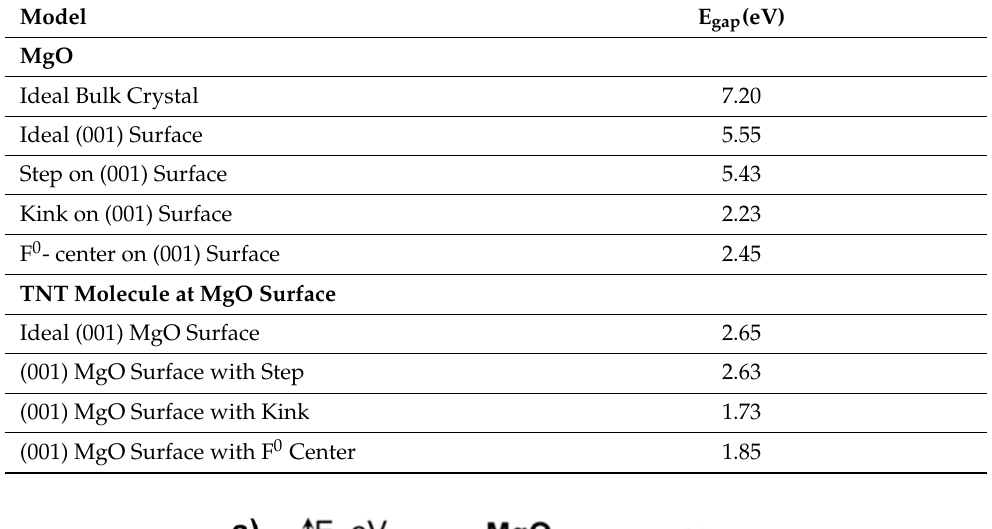
Table 1. Calculated band gaps E gap (eV) for (001) MgO surface (clean and with defects) and for individual TNT molecule adsorbed at the same surfaces.